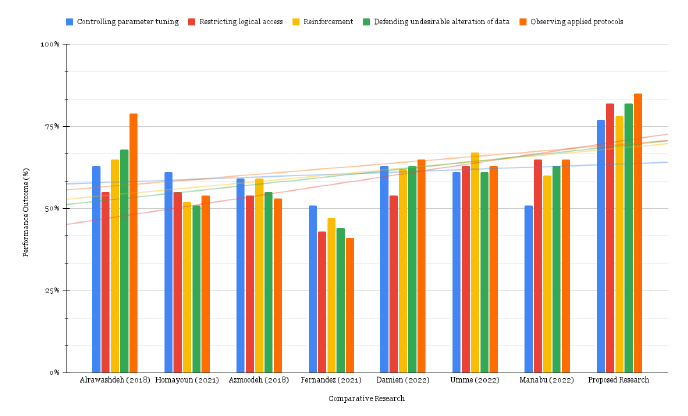
Figure 7. Comparative Analysis